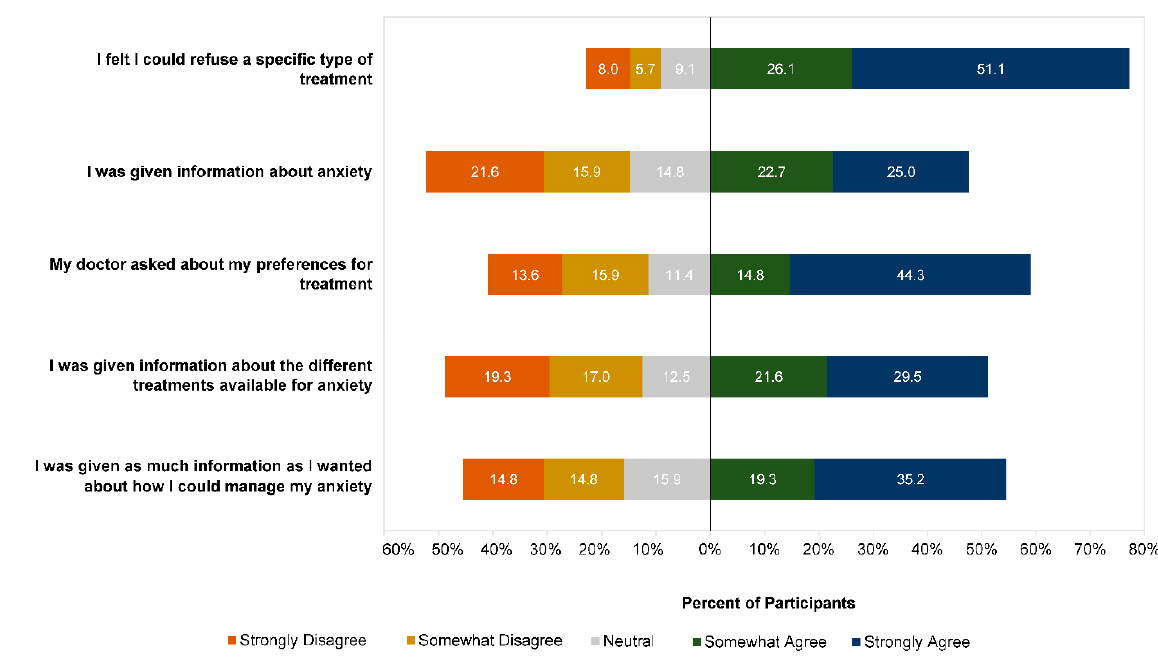
Figure 6. Participant ratings (n = 88) of GP treatment approach in the last 12 months. 3.4.2. Perceptions of GP—Previous 12 Months Participants again indicated positive perceptions of their GP in the past 12 months, with at least 70% of participants somewhat or strongly agreeing with all statements about their experience (Figure 7).